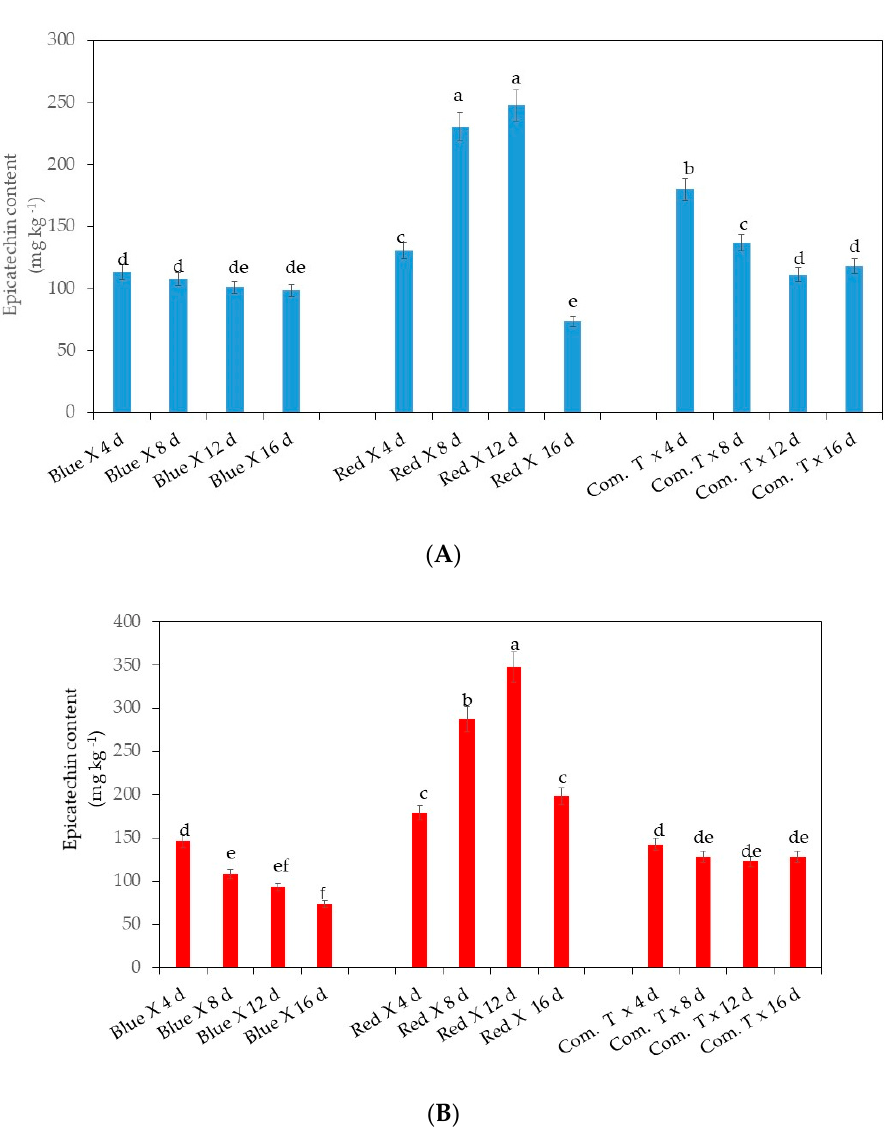
Figure 4. ( A ) . Influence of LED light exposure on skin epicatechin content in avocado cultivar Fuerte. ( B ) . Influence of LED light exposure on skin epicatechin content in avocado cultivar Hass. The exposure of fruit to blue or red LED light was for 6 h per day during storage. Number of replicates per treatment n = 5. Mean values of bars marked by different letters were significantly different at p < 0.05, according to Fisher’s protected LSD test. Blue, blue LED light; Red, red LED light; Com. T, commercial treatment.